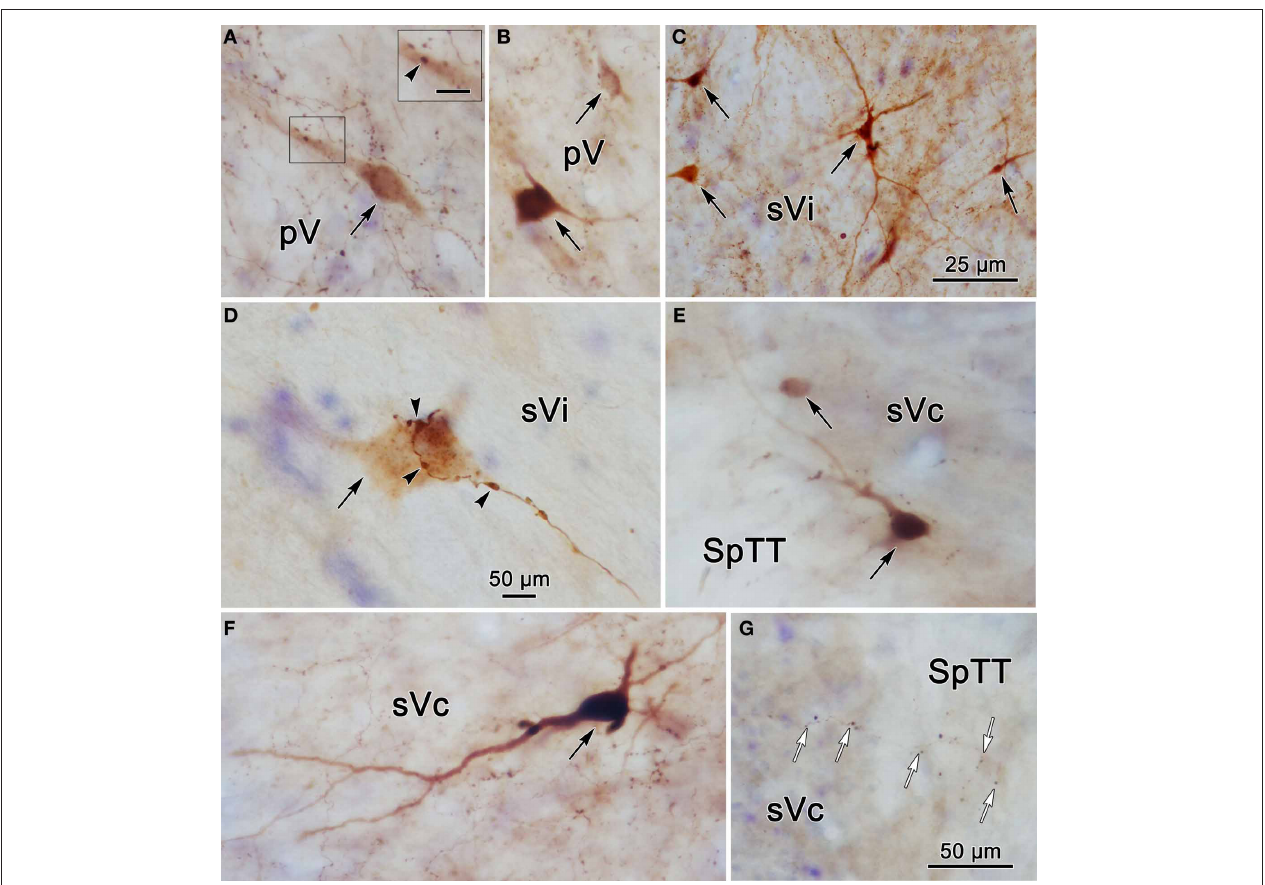
FIGURE 5 | Photomicrographsoflabeledneurons(blackarrows) and axonswithinthe trigeminalcomplexfollowingthe injectionillustratedin Figure2A. Panels (C,E,F) are fromtheipsilateral sideandpanels (A,B,D,G) are fromthecontralateralside.Panels (C) and (D) are lowandhighmagnification photomicrographs,respectively,ofcellsinsVi.Closeassociations(arrowheads)